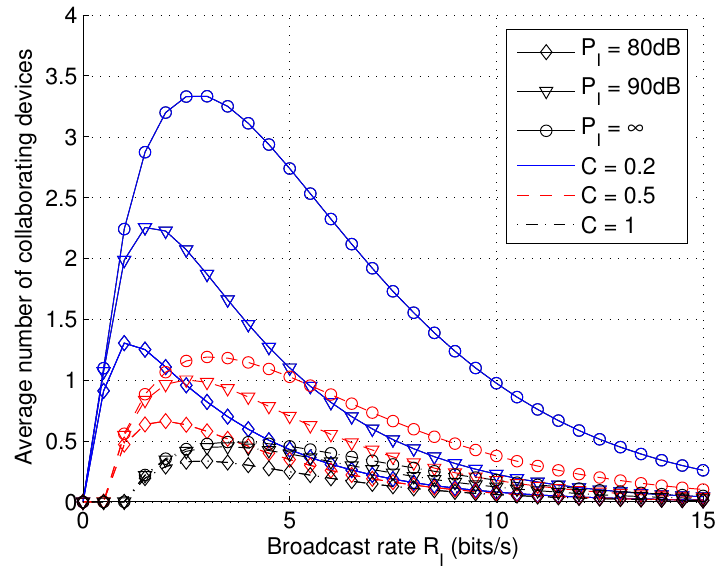
Figure 8. The average number of collaborating devices ¯ N as a function of broadcast rate R I with varying transmit power P I and capacity demand C ( λ u = 10 − 4